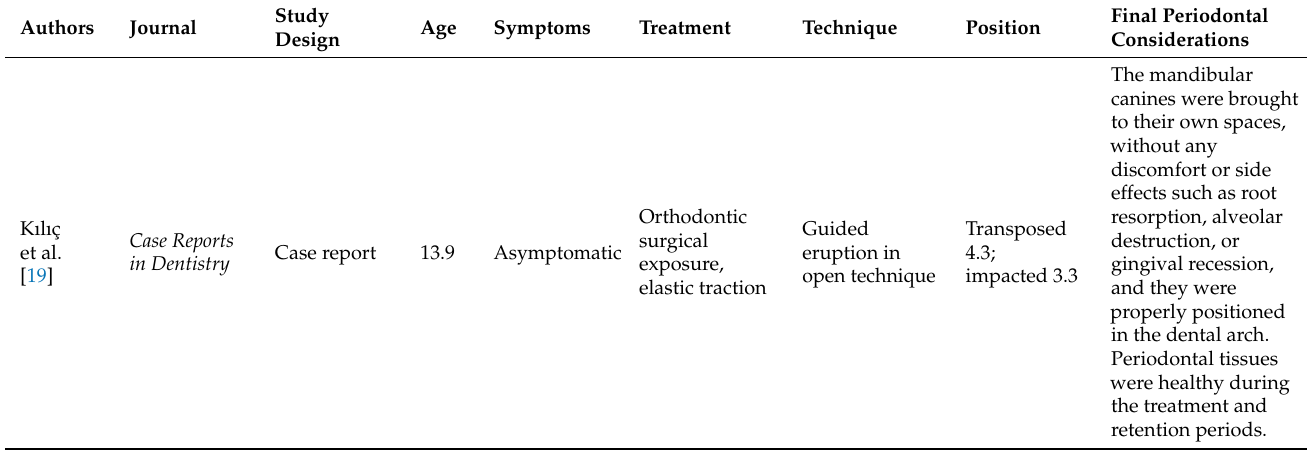
Table 3. Descriptive summary of item